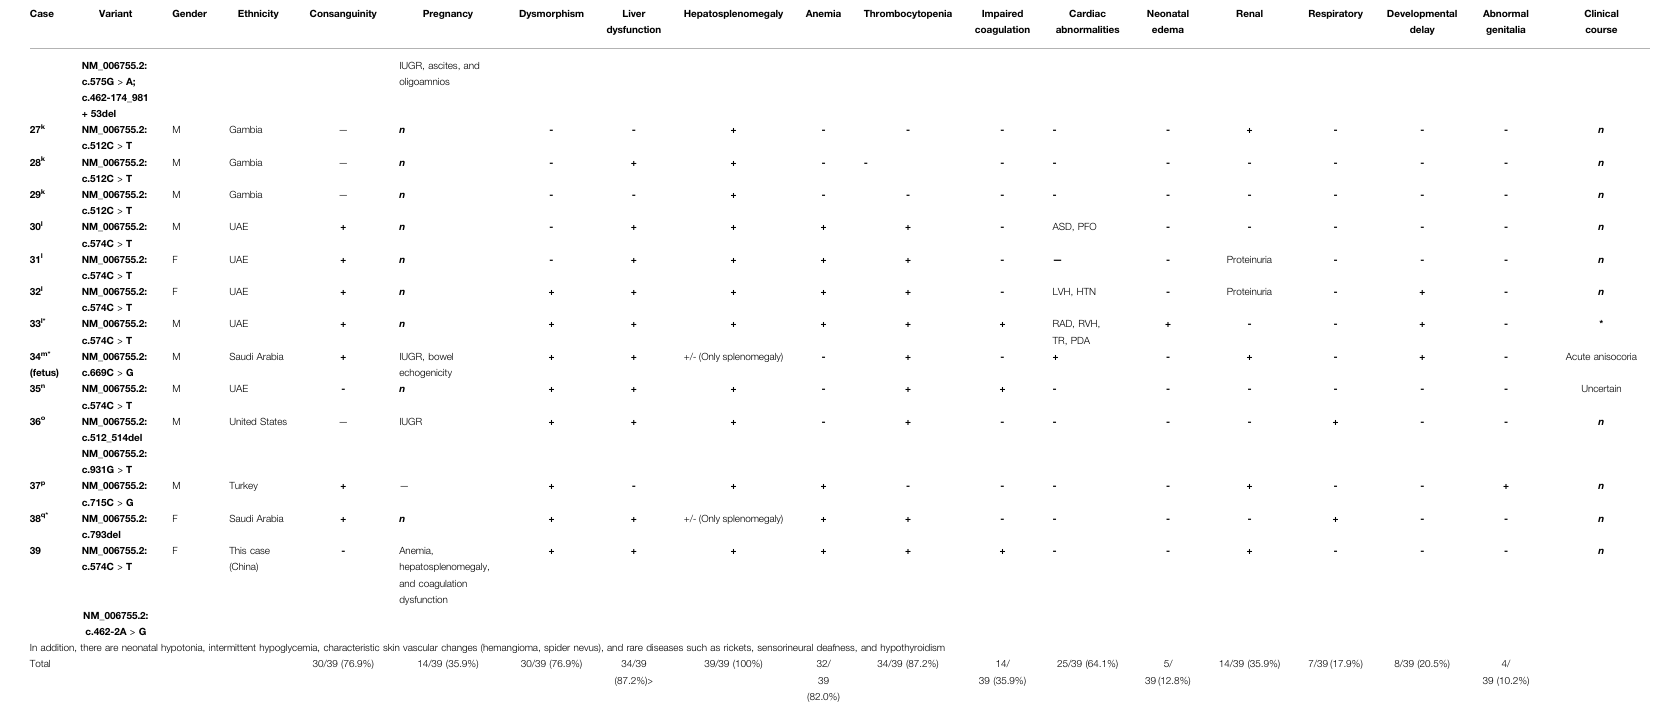
TABLE 3 | ( Continued ) Summary of clinical manifestations in the current patients with TALDO de fi